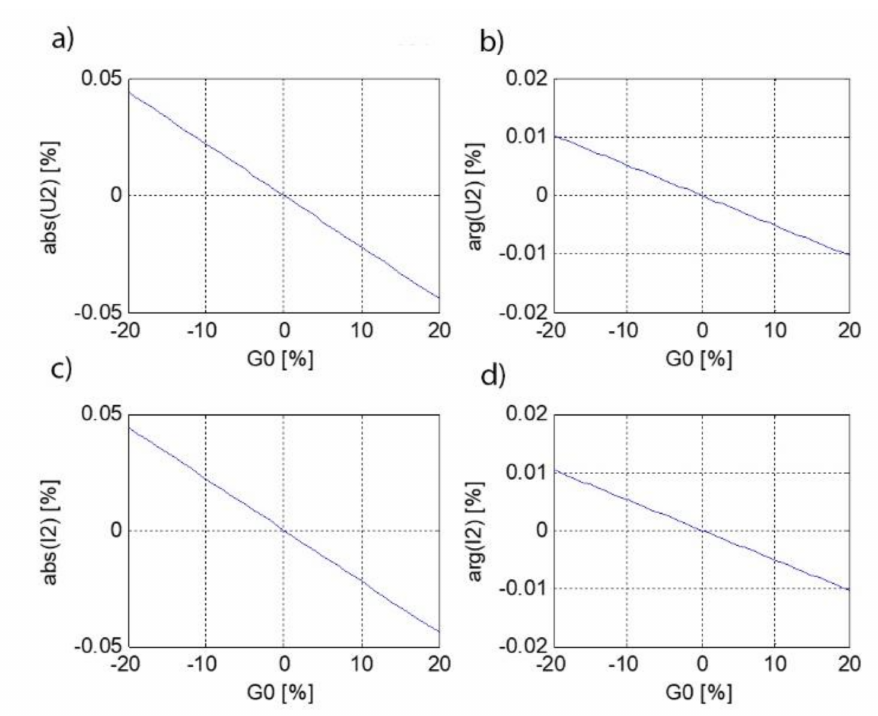
Figure 24. Changes of wave parameters depending on G 0 at f = 1 MHz; ( a ) U 2 voltage modulus, ( b ) U 2 argument, ( c ) I 2 modulus, ( d ) I 2